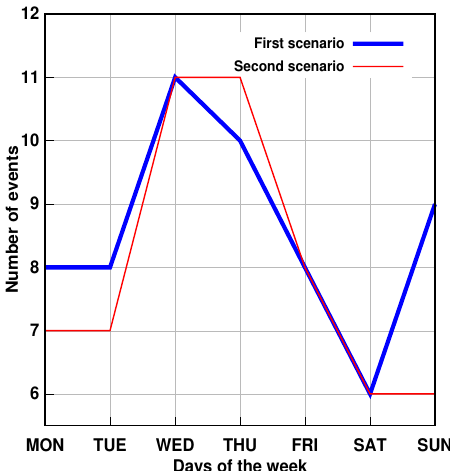
Figure 12. AGGIR Toileting